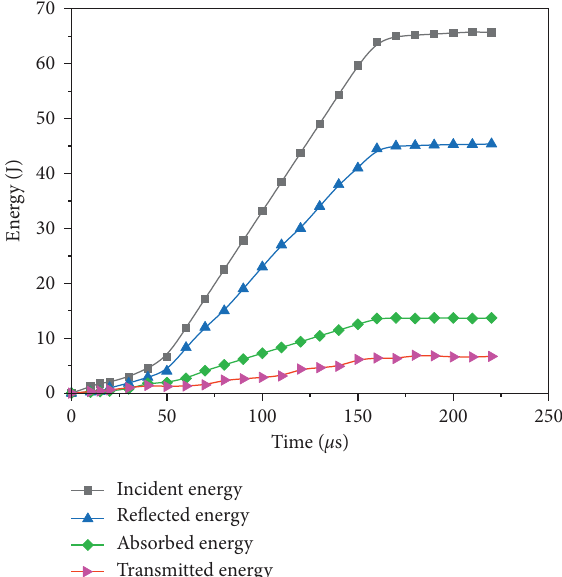
Figure 11: Energy-time curve of the red sandstone sample in the SHPB tensile test.